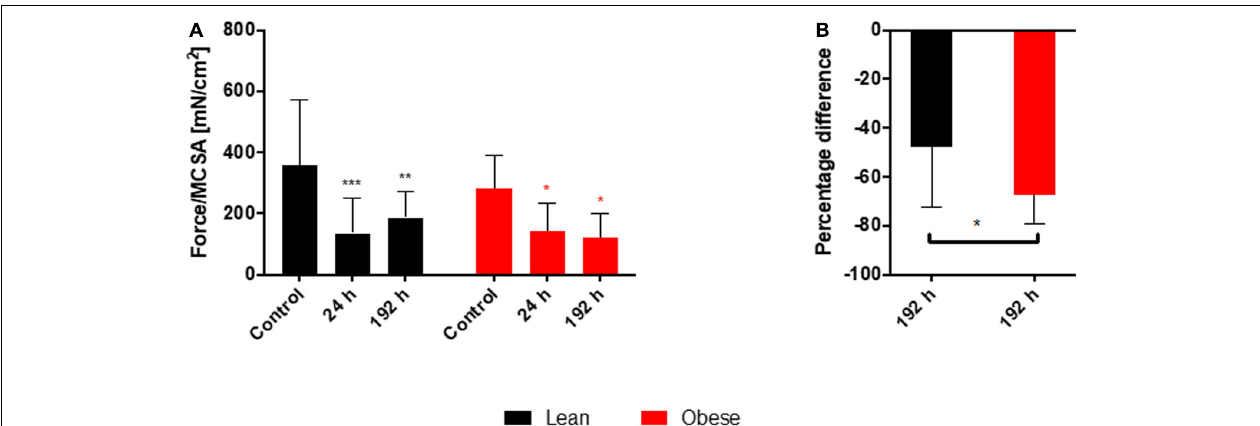
FIGURE 10 | Decreased recovery of the muscle force in obese animals 192 h post trauma. Evaluation of muscle force during regeneration process of injured muscle extensor iliotibialis anticus of lean and obese control mice as well as 24 and 192 h post trauma ( n = 6). (A) Time-dependent development of muscle force normalized to muscle cross sectional area (Force/MCSA [mN/cm 2 ] ± SEM). Statistical significance was determined using two-way ANOVA followed by an uncorrected Fisher’s LSD test ( α = 0.05). (B) Comparison of Force/MCSA [mN/cm 2 ] between lean and obese mice 192 h post trauma normalized to the respective control. Statistical significance was determined with an unpaired, one-tailed t -test ( α = 0.05). * p < 0.05, ** p < 0.01, *** p <